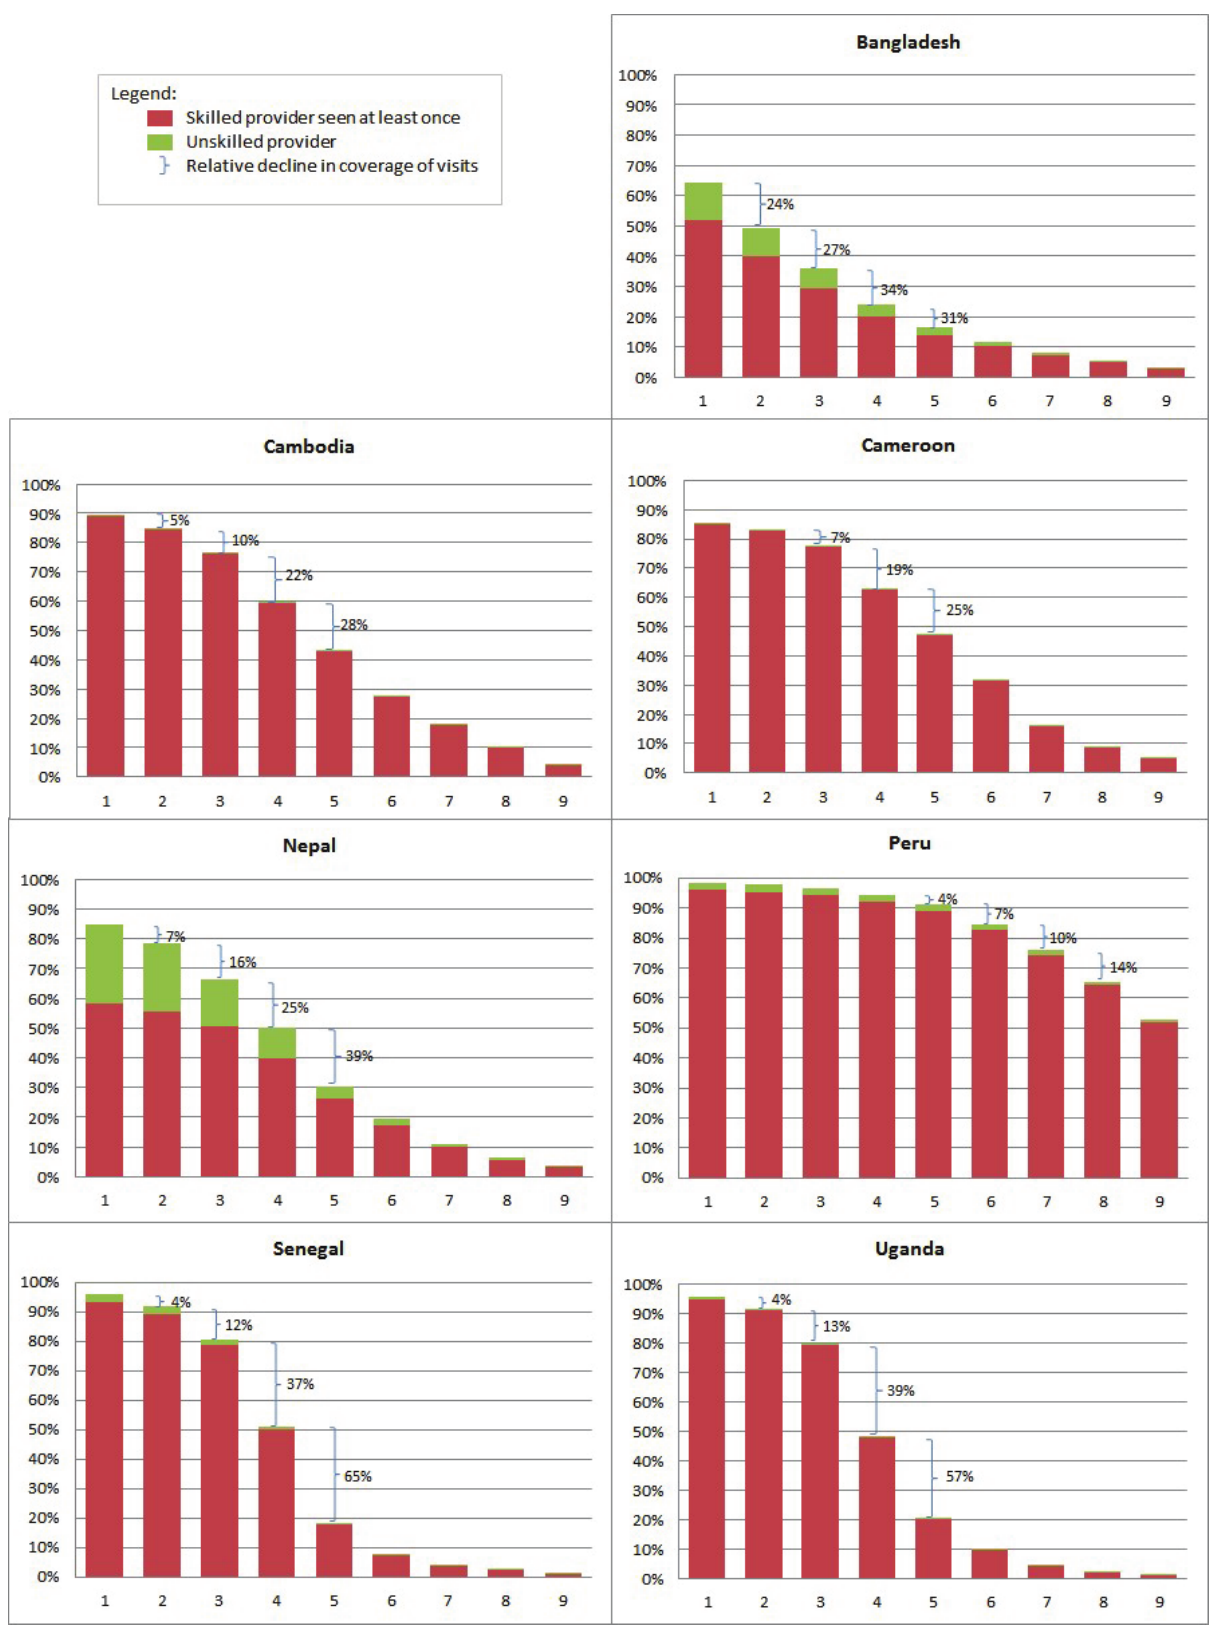
Figure 3. Cumulative percentage of women who had a birth in the five years preceding the DHS surveys by number of ANC visits and type of provider for their most recent live birth, in seven Countdown